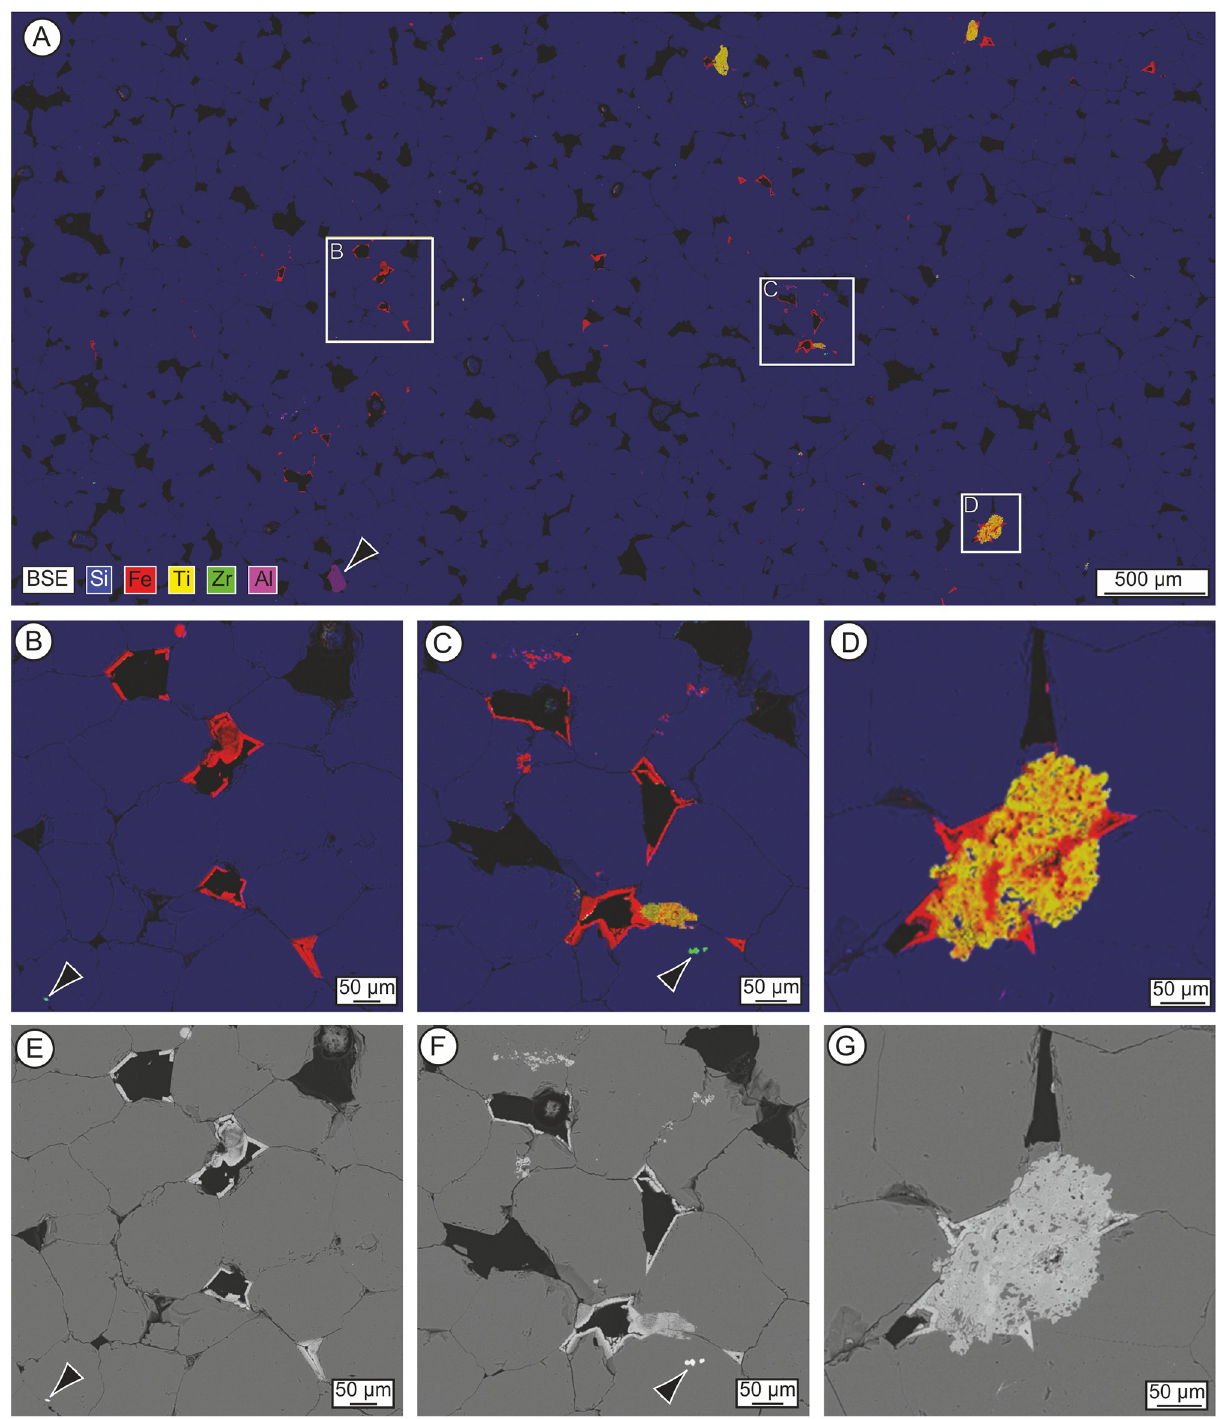
Fig 14. Energy-dispersive spectrometry (EDS) net intensity composite elemental maps (A-D) and back-scattered electron (BSE) images (E-G) of polished thin-section SH3B from the Phillips’ Core. (A) Mosaic EDS map (3.2 μ m pixel size) overlain with BSE micrograph (5100 × 2500 pixels, 1.6 μ m pixel size). Quartz is represented in blue (Si), iron oxides/hydroxides in red (Fe), titanium oxides in yellow (Ti), zircon in green (Zr) and kyanite (arrow) in magenta (Al). (B-D) Image detail of the rectangles shown in (A). Arrows indicate ~5–10 μ m zircon grains. (E-G) BSE images (749 nm pixel size) of the areas shown in (B-D). These images are reproduced under a CC BY 4.0 license, with permission from The Trustees of the Natural History Museum, original copyright (2019).